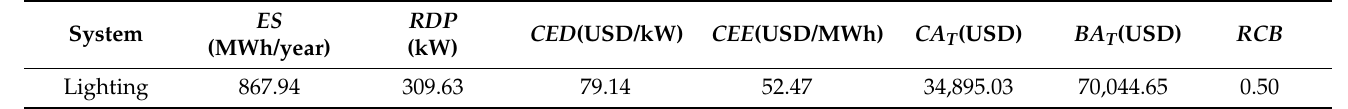
Table 7. Economic Feasibility Analysis of the Lighting